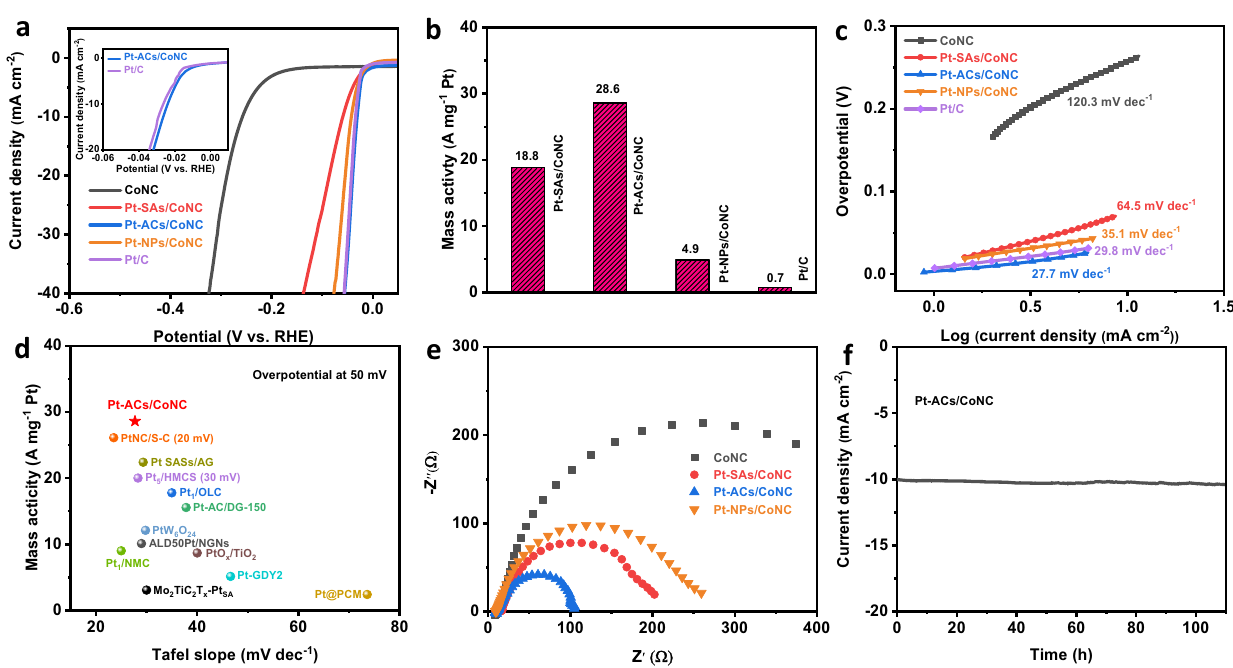
Fig. 3 Electrocatalytic performance of Pt-ACs/CoNC and reference HER catalysts. a HER polarization curves of CoNC, Pt-SAs/CoNC, Pt-ACs/CoNC, Pt-NPs/CoNC and Pt/C with same total loading on the working electrode with same geometric surface area in 0.5 M H 2 SO 4 solution. b Mass activity of state-of-the-art Pt/C, Pt-SAs/CoNC, Pt-ACs/CoNC and Pt-NPs/CoNC at the overpotential of 50 mV with same total loading on the working electrode. c Corresponding Tafel slope. d Comparison of Tafel slope and mass activity for various Pt-based HER catalysts in 0.5 M H 2 SO 4 solution. Values were plotted from references (Supplementary Table 2). e EIS Nyquist plots of CoNC, Pt-SAs/CoNC, Pt-ACs/CoNC and Pt-NPs/CoNC obtained at